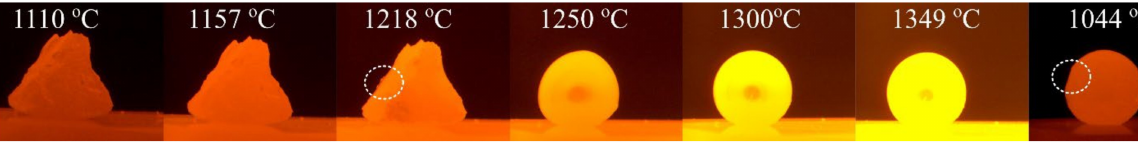
Figure 3. Photos of the Fe-26Si-9B particle on Si 3 N 4 substrate under 10 − 4 atm.